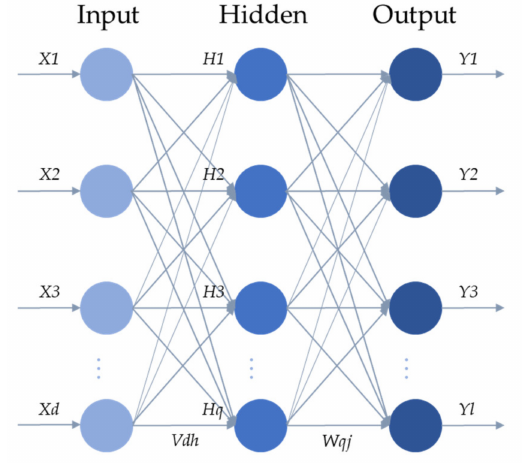
Figure 5. Structure of BP neural